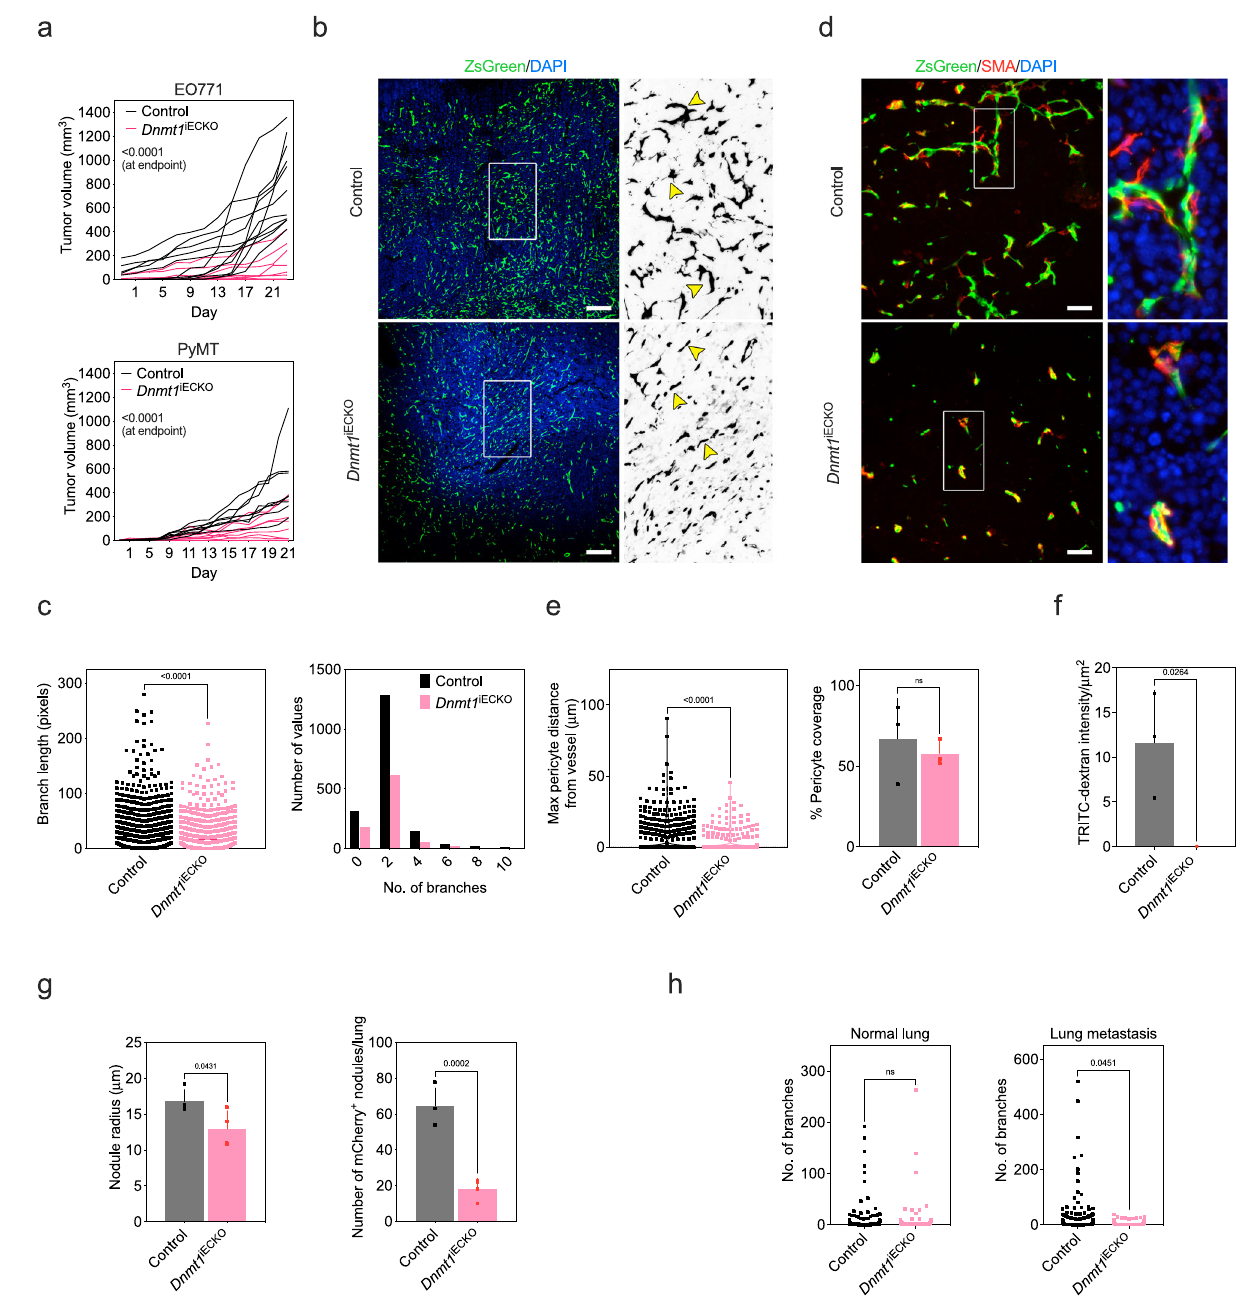
Fig.1|Conditionaldeletionof Dnmt1 inECsimpairstumorgrowthandreduces vascular density. a EO771 (top) or PyMT (bottom) mammary tumors orthotopi- cally engrafted in control versus Dnmt1 iECKO mice. Tumor volumes were measured every other day with calipers (EO771; n = 11 , control and n = 9 , Dnmt1 iECKO :PyMT; n = 8 , control and n = 8 , Dnmt1 iECKO ). For EO771, results were statistically signi fi cant beginningatday15;forPyMTresultswerestatisticallysigni fi cantbeginningonday 16. Results were analyzed using ANOVA and Sidak ’ s multiple comparisons test. b ZsGreen + tumor vasculature from the indicated mice. Boxed areas at right were zoomed 5× for detail and converted to an 8-bit binary image, and then inverted to reveal lateral branches/ fi lopodia. Arrowheads point to either highly branched or straighter and narrower vessels in control versus Dnmt1 iECKO mice, respectively. Scale bars=100 μ m. c Quanti fi cation of vessel branch length presented as a dot plot or histogram to show the distribution of branch lengths and numbers of branches( n = 3 individualtumorsandninehistologicalsectionspergroup).Results